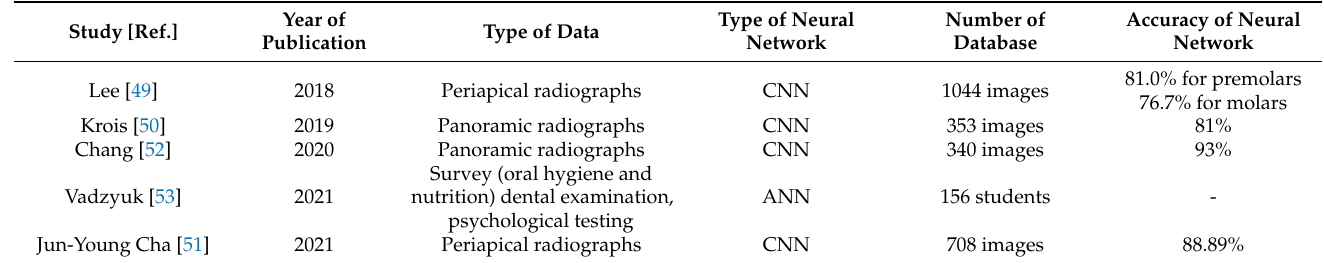
Table 5. Baseline characteristics of the studies included in review by studying neural networks in